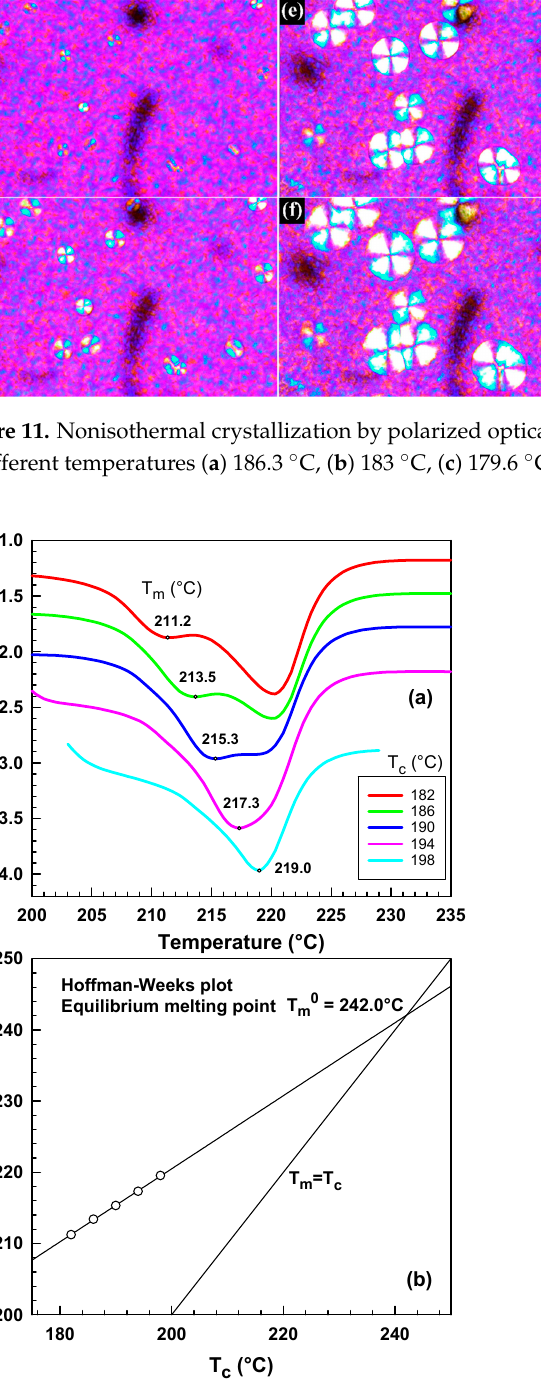
Figure 12. ( a ) Determination of melting temperature after isothermal crystallization at various temperatures, ( b ) Hoffman–Weeks plot for equilibrium melting point determination, melting point of peak I vs. crystallization temperature.